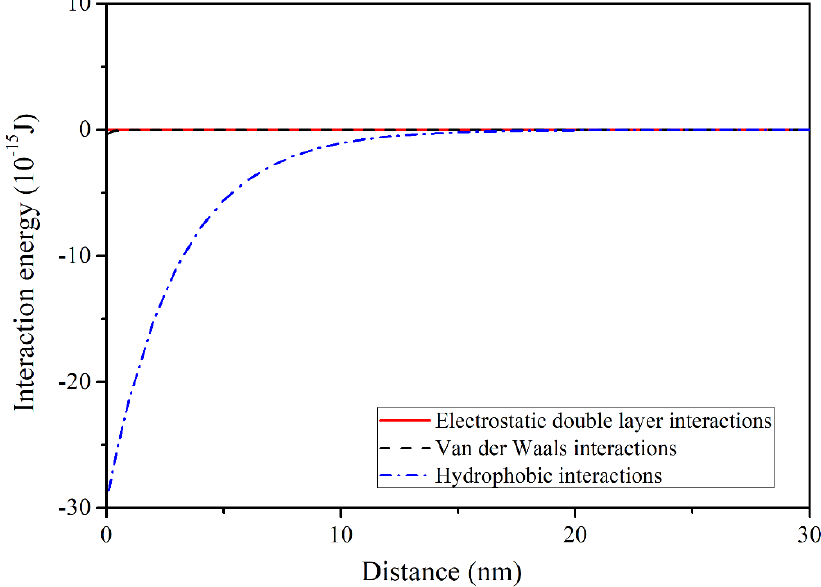
Figure 8. The total interaction energy between seeds and minerals as a function of h.